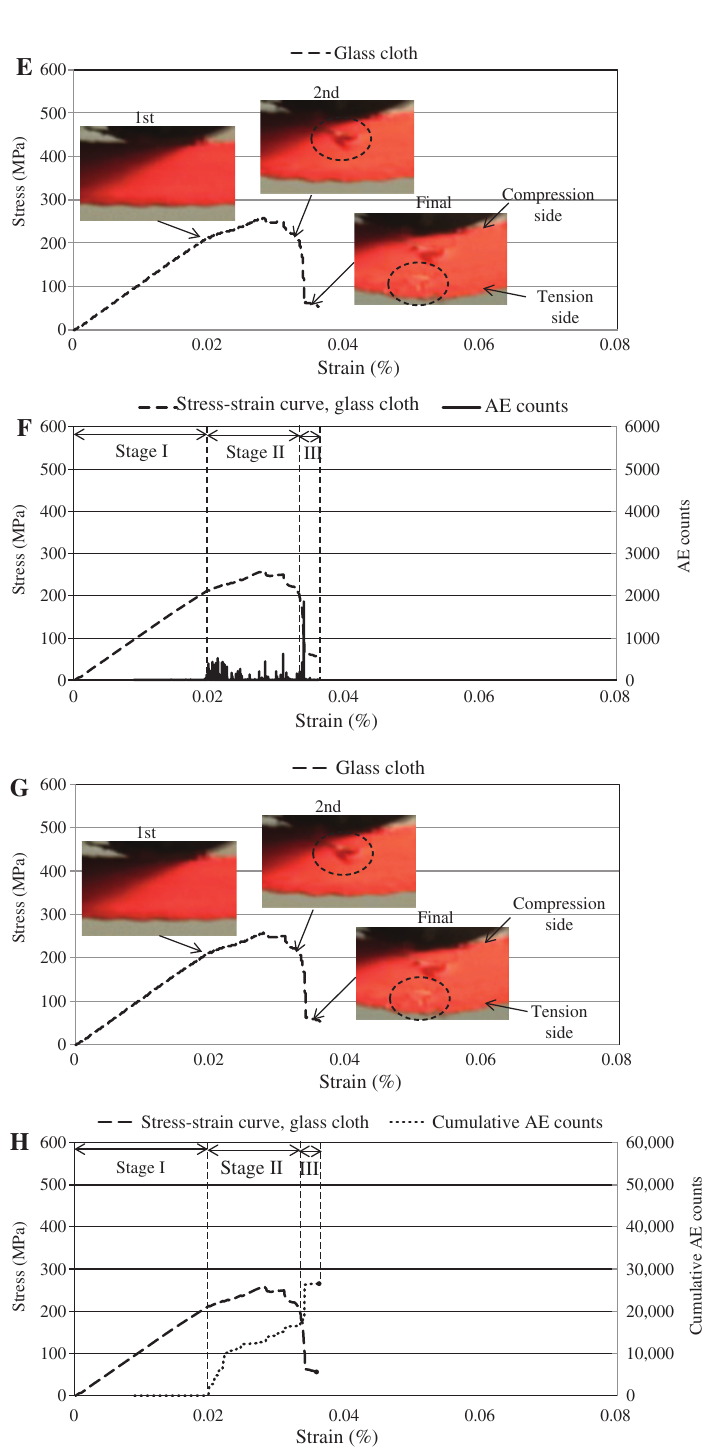
Figure 10 Three-point bending stress-strain curves associated with in situ macroscopic observations of the fractured specimens and AE events: (A–D) glass roving and (E–H) glass cloth.